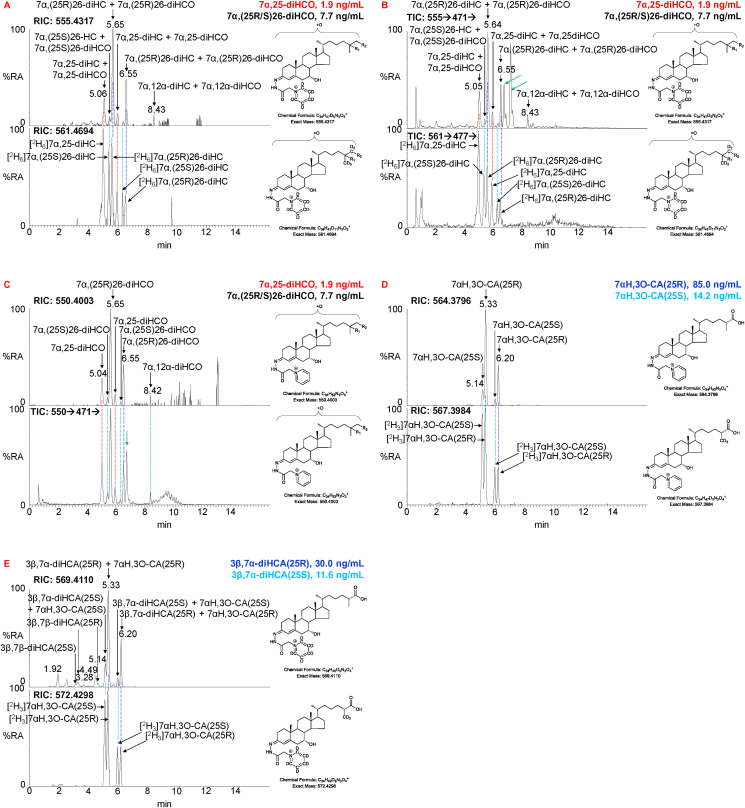
LC-MS separation of GP-derivatised dihydroxycholesterols (diHC), dihydroxycholestenones (diHCO), dihydroxycholestenoic (diHCA) and hydroxyoxocholestenoic (H,O-CA) acids. (A) RIC for the [M]+ ions of (upper panel) 7α,25-diHC + 7α,25-diHCO and 7α,(25R/S)26-diHC + 7α,(25R/S)26-diHCO (555.4317 ± 5 ppm) found in plasma, and (lower panel) [2H6]7α,25-diHC and [2H6]7α,(25R/S)26-diHC (561.4694 ± 5 ppm) over a 17 min gradient. (B) MS3 ([M]+→[M-Py]+→) TICs for (upper panel) 7α,25-diHC + 7α,25-diHCO and 7α,(25R/S)26-diHC + 7α,(25R/S)26-diHCO (555.4 → 471.4→) found in plasma and (lower panel) [2H6]7α,25-diHC and [2H6]7α,(25R/S)26-diHC (561.5 → 477.4→) over a 17 min, gradient. Note the additional peaks in the upper panel labelled by green arrows arise from fragmentation of the [M+2]+ peaks with monoisotopic m/z of 553.4161. In the sterol structures R1 is OH in 7α,25-diHC and R2 is OH in 7α,(25R/S)26-diHC. (C) RIC for the [M]+ ions (550.4003 ± 5 ppm, upper panel) and TICs for the MS3 fragmentation (550.4 → 471.4→, lower panel) of 7α,25-diHCO and 7α,(25R/S)26-diHCO found in plasma. Note the additional peak in the lower panel labelled by the green arrow arises from fragmentation of the [M+2]+ peak with monoisotopic m/z 548.3847. (D) RIC for the [M]+ ions of (upper panel) 7αH,3O-CA(25R/S) (564.3796 ± 5 ppm) found in plasma and (lower panel) [2H3]7αH,3O-CA(25R/S) (567.3984 ± 5 ppm) over a 17 min gradient. (E) RIC for the [M]+ ions of (upper panel) 7αH,3O-CA(25R/S) + 3β,7α-diHCA(25R/S) (569.4110 ± 5 ppm) found in plasma and (lower panel) [2H3]7αH,3O-CA(25R/S) (572.4298 ± 5 ppm) over a 17 min gradient. Coloured dashed lines indicate the coincidence of peaks of the same oxysterol. Chromatograms recorded over a 37 min gradient can be found in Supplemental Fig. S6. MS3 spectra are presented in Supplemental Figs. S7 and S8. (For interpretation of the references to colour in this figure legend, the reader is referred to the Web version of this article.)